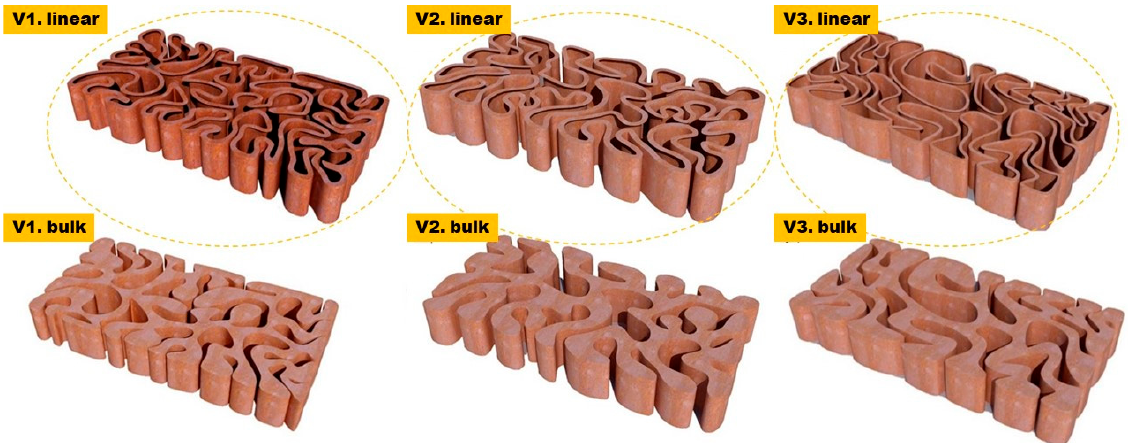
Figure 1. Exhibits the three design families V1, V2 and V3 of the biodigital clay bricks; each design family includes linear and bulk models. The two examples exhibited in the figure of each design family show the 0.55 thickness linear brick model and the 55% density bulk brick model that are tested for their mechanical properties in the current study.